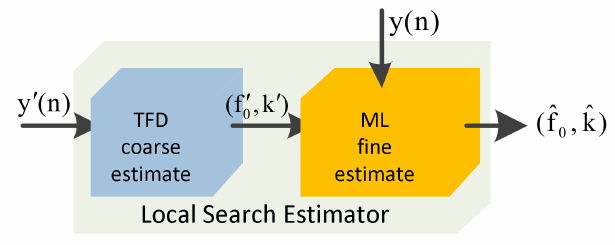
Figure 4. Schematic diagram of local search